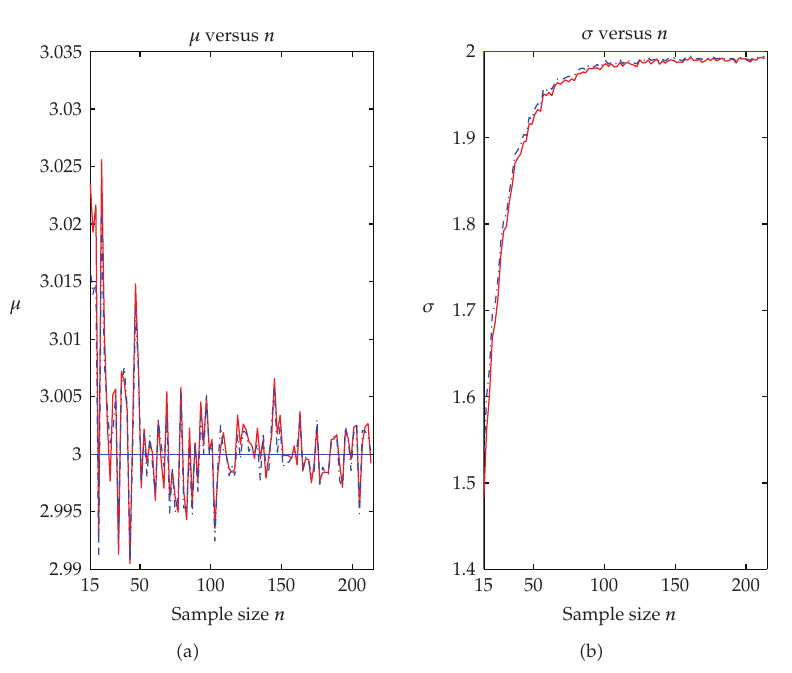
Figure 4: Grouped data: τ 1 (cid:8) − 1 . 5, τ 2 (cid:8) 1, τ 3 (cid:8) 3 . 5, τ 4 (cid:8) 6, τ 5 (cid:8) 8 . 5. Type I left censored data: τ (cid:8) − 1 . 5 .